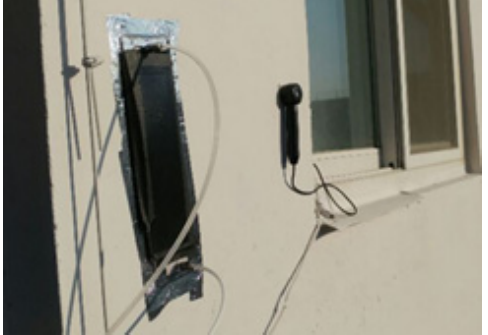
Figure 9. Installed photoreactor and UV radiometer on the rooftop.